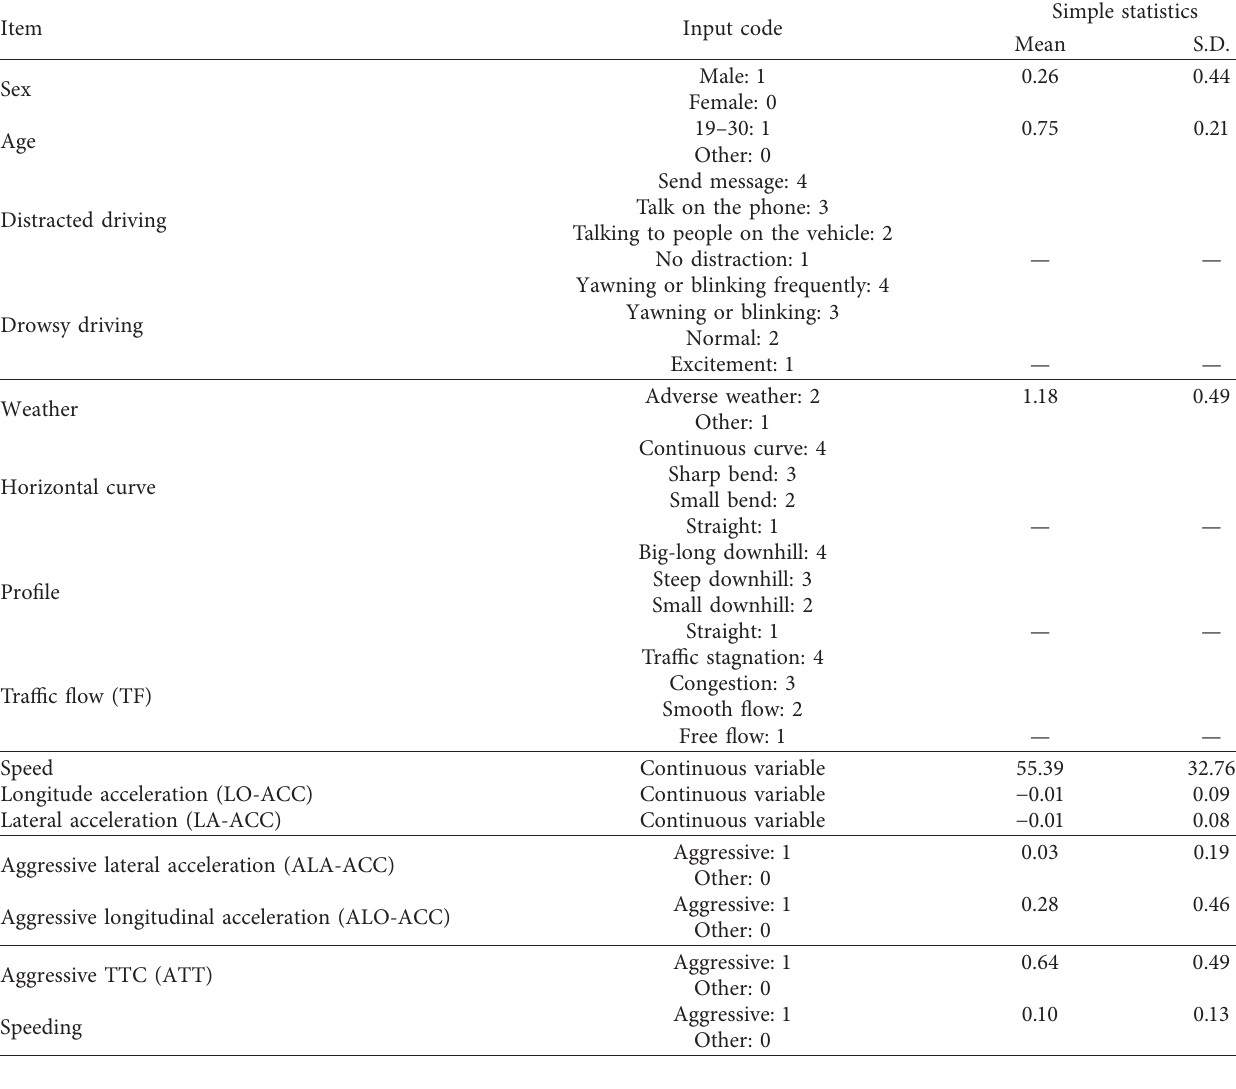
Table 4: Definitions of variables, their codes, and related statistics.